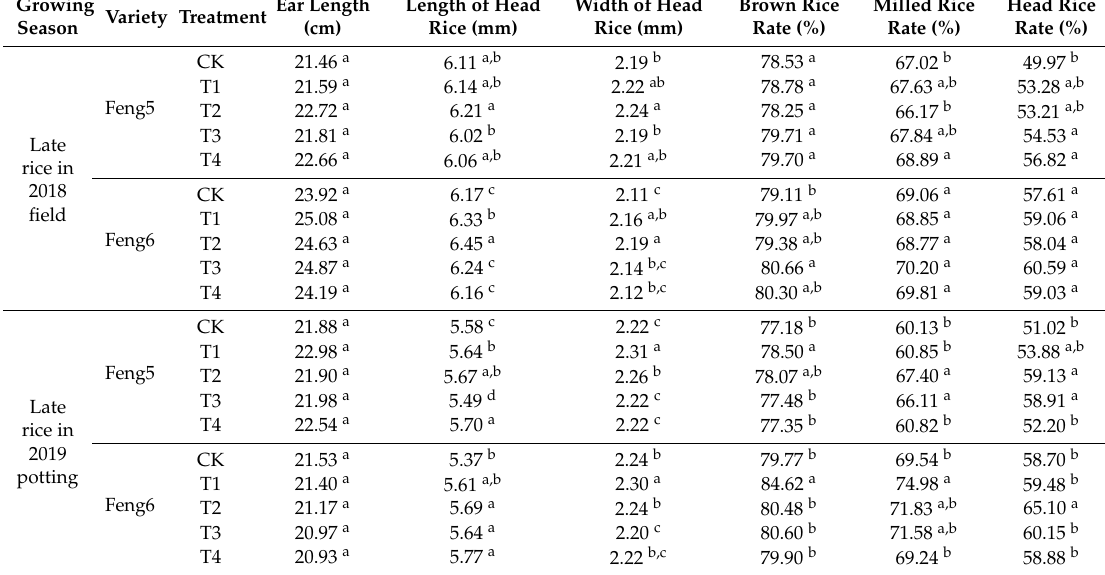
Table 4. Changes in the quality of giant rice under di ff erent nitrogen treatments.